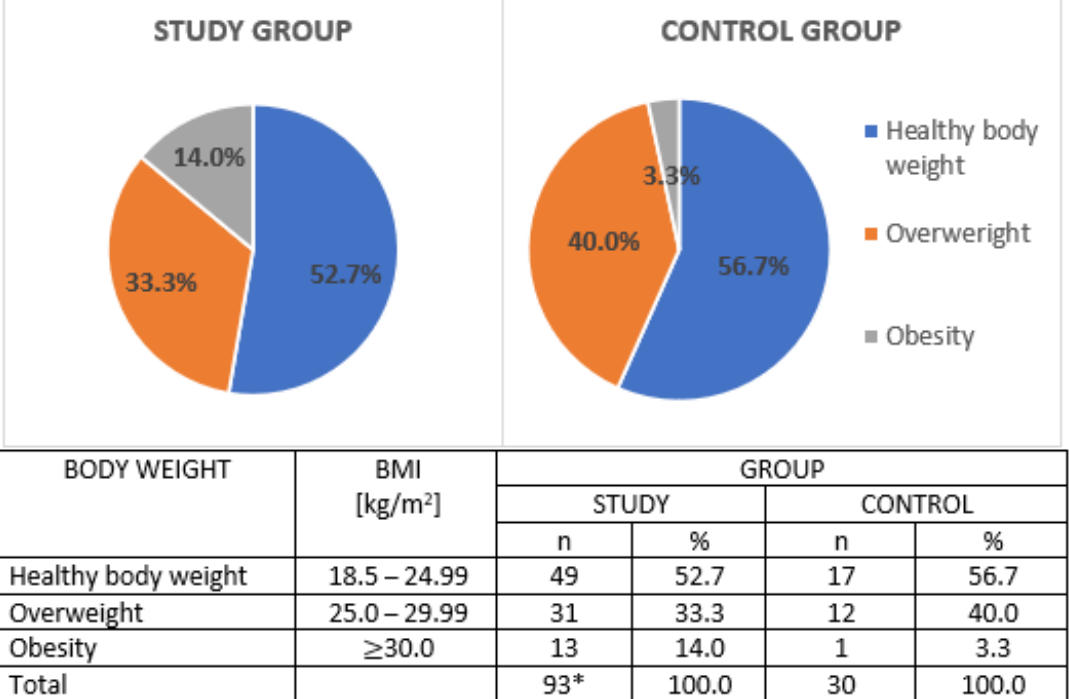
Figure 2. Body weight categories in studied groups; BMI: Body Mass Index; n : sample size; %: percentage. *: 2 patients from study group with BMI under 18.5 were excluded from the analysis.